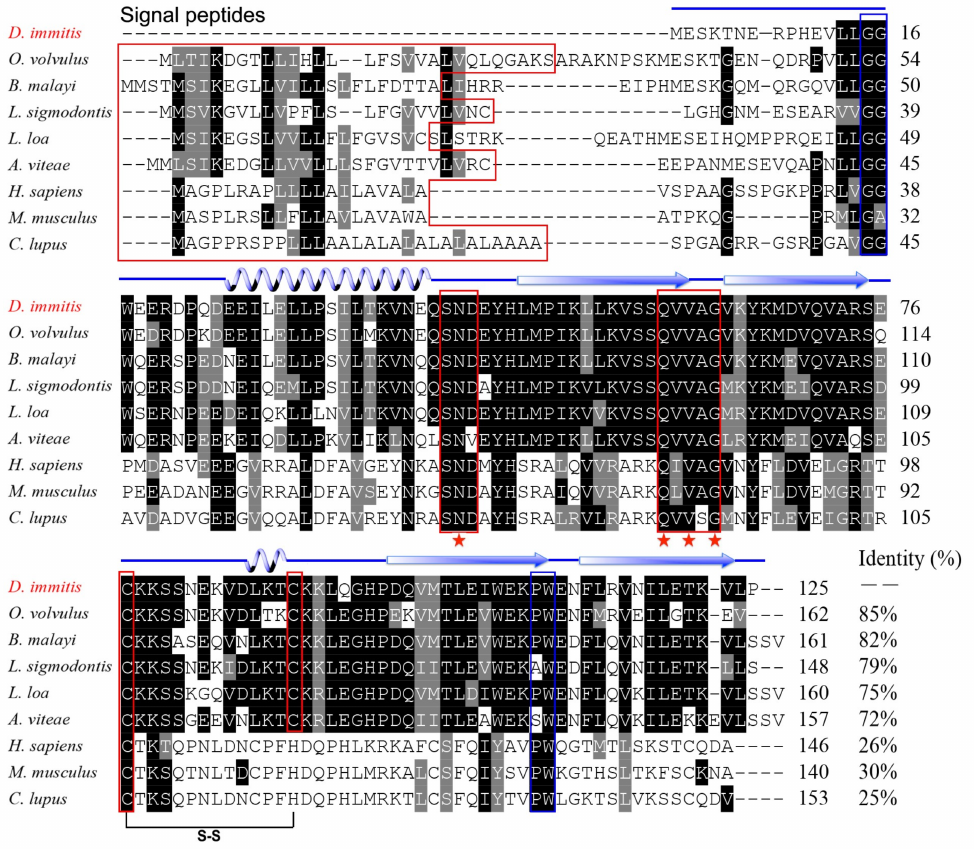
Figure 1. Sequence alignment of Dirofilaria immitis cysteine protease inhibitor ( Di -CPI). Alignment of the deduced Di -CPI amino acid sequence with those of homologous proteins from nematodes ( Onchocerca volvulus , AAA29423.1; Brugia malayi , AAD51086.1; Litomosoides sigmodontis , AAF35896.1; Loa loa , XP_003147913; Acanthocheilonema viteae , AAA87228.1) and mammals ( Mus musculus , NP_034106.2; Human, AAH13083.1; Canine, XP_003639869.1) was performed using Clustal X software version 2 and shaded using BOXshade version 3.21. Predicted secondary structural elements, including strands and helices, are shown above the alignment as arrows and loops, respectively. The Q-x-V-x-G motif and SND motif are enclosed in red boxes. A conserved glycine residue in the N-terminal region and the PW hairpin loop in the C-terminal region are enclosed in the blue boxes. N-terminal signal peptides are enclosed in a red